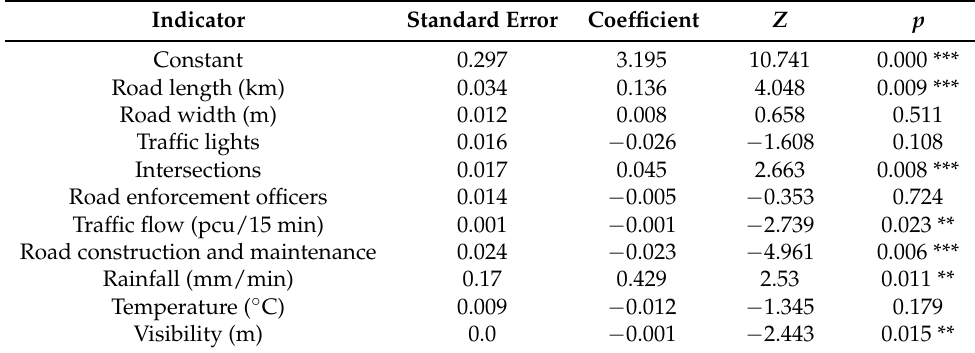
Table 6. Results of parameter estimation of the Poisson regression model.